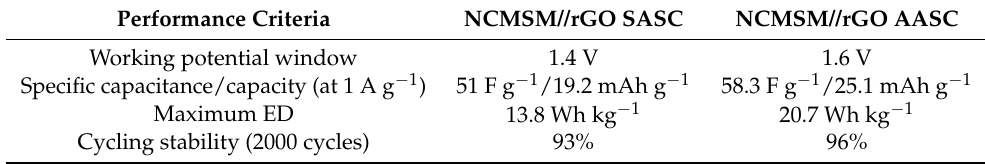
Table 1 differentiates the electrochemical performance of two kinds of asymmetric devices. The device with an aqueous electrolyte exhibited high electrochemical